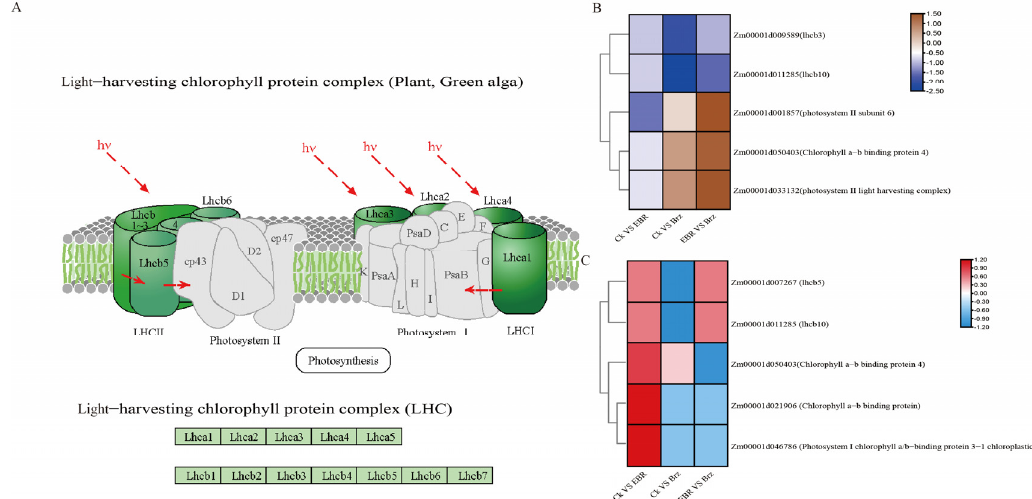
Figure 8. Differences in photosynthesis antenna proteins expression as per the transcriptome and proteome analyses. ( A ) Light-harvesting chlorophyll protein complex in the KEGG pathway database. ( B ) DEGs for photosynthesis antenna proteins as per transcriptome analysis. ( C ) DEPs regarding photosynthesis antenna proteins as per proteome analysis.